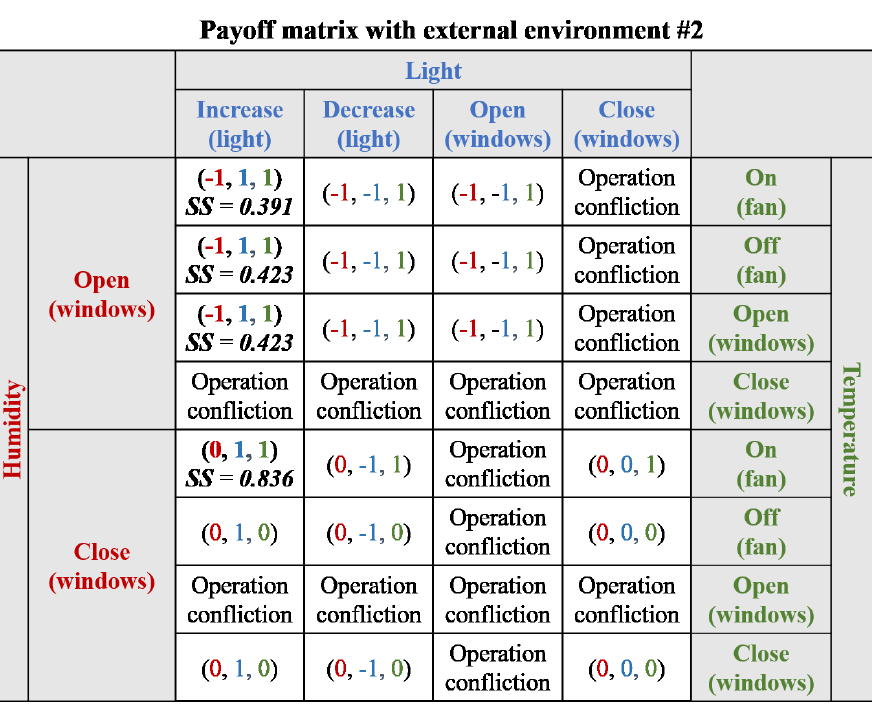
Figure 11. Payoff matrix for Scenario #3 with external environment #2 ( α = 0.5 and β =